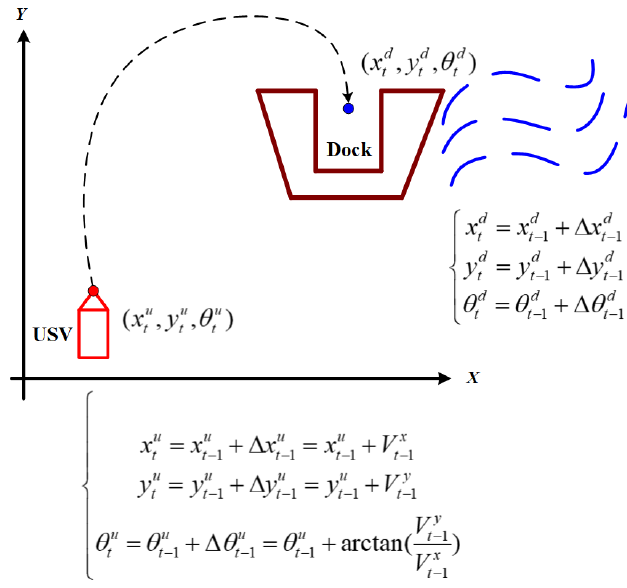
Figure 6. The principle of automatic docking design with moving dockyard.